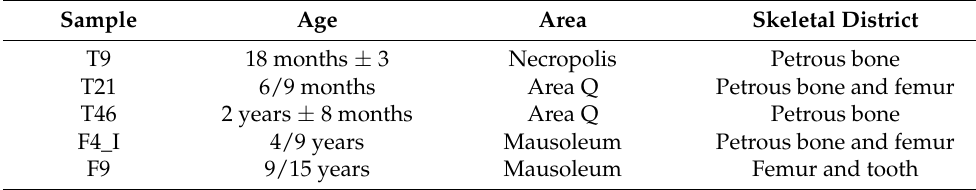
Table 1. Samples’